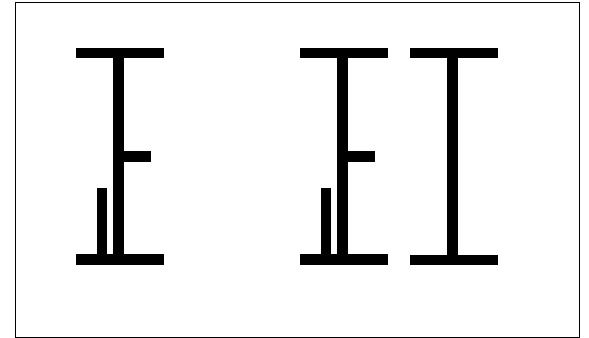
Figura 2. Mediana do tempo total de movimento ao longo das fases para os três grupos.